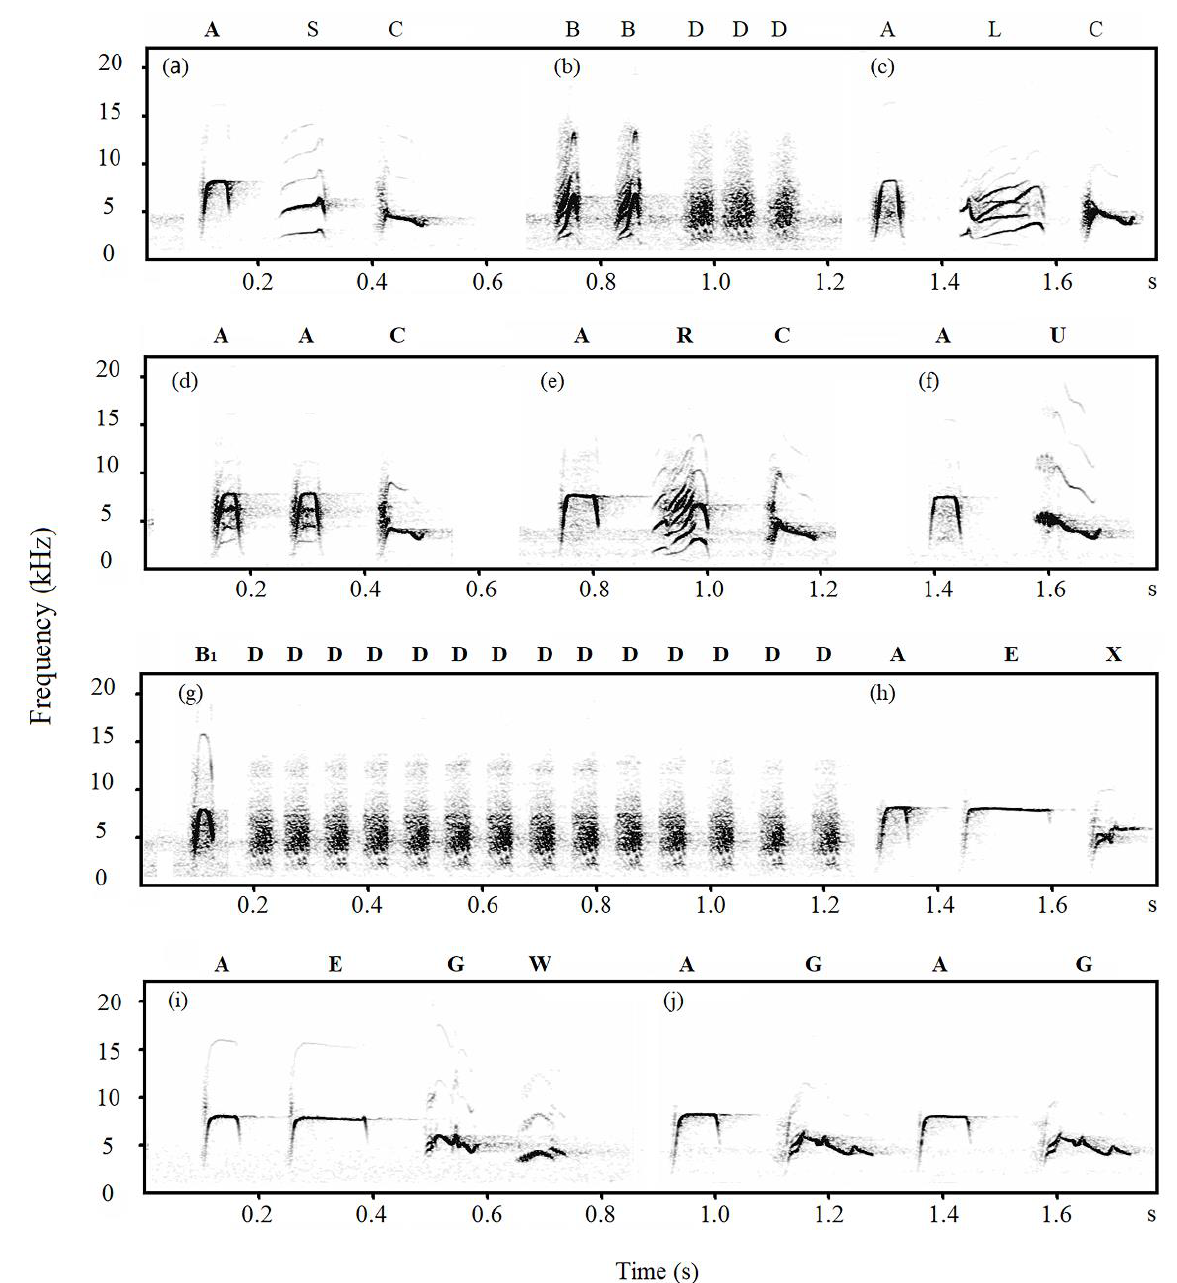
Figure 3. Spectrographic illustration of alarm calls of Henan-tits (capital letters are notes and lowercase letters are calls).